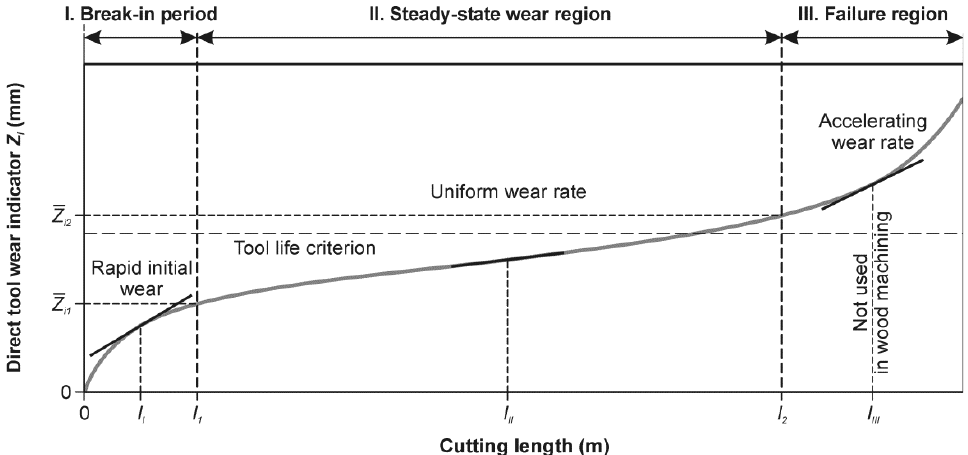
Figure 7. Classic wear curve showing the evolution of wear during machining.